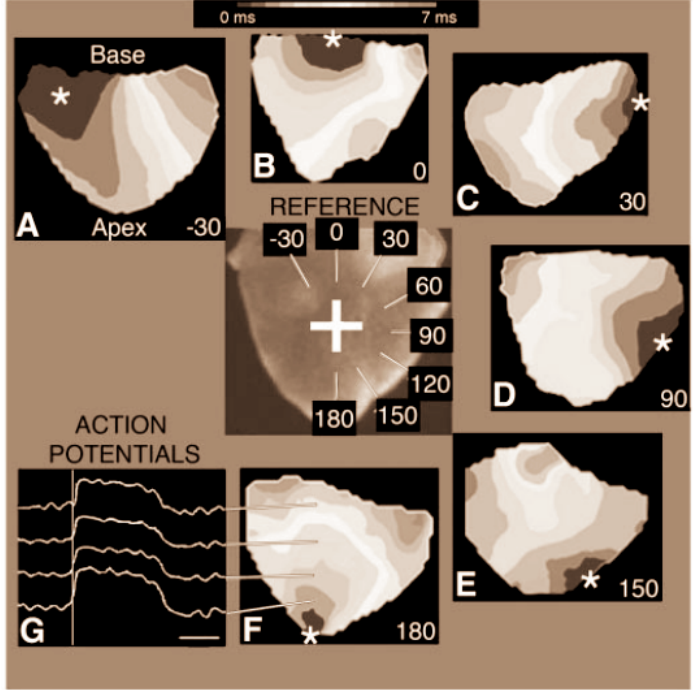
Figure 5. Transitions in ventricular conduction pattern detected by OM [159]. Isochrome maps and the angle value measurement system of ventricular activation were generated from the recordings of the posterior side of chicken hearts at HH stages 29–35. ( A – F , G ) Waveforms of optically records APs from several locations on the posterior side of the heart. “REFERENCE” indicates how angle values between − 30 ° to 180 ° are assigned to isochrones map based on the site of the initial breakthrough of AP that is indicated by the asterisk (*). Bar = 20 ms in ( G ).